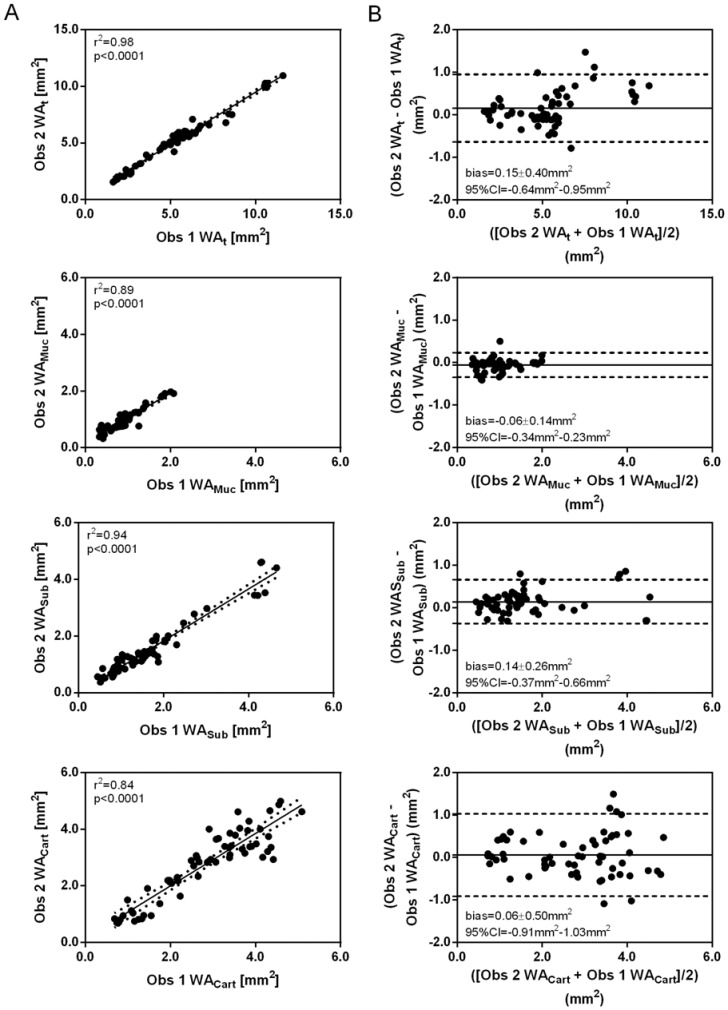
Correlation and Bland-Altman analysis for fresh OCT airway wall component measurements for two observers for all slices.A. There was a significant correlation between observer 1 and 2t (r2 = 0.98, p<0.0001), WAmuc (r2 = 0.89, p<0.0001), WAsub (r2 = 0.94, p<0.0001) and WAcart (r2 = 0.84, p<0.0001). B. Bland-Altman analysis indicates a small bias between observers for WAt (bias = −0.15±0.40, 95% CI = −0.64–0.95), WAmuc (bias = 0.06±0.14, 95% CI = −0.34–0.23), WAsub (bias = 0.14±0.26, 95% CI = −0.37–0.66), WAcart (bias = −0.06±0.50, 95% CI = −0.91–1.03). Solid lines represent the bias and dotted lines represent the 95% confidence intervals.